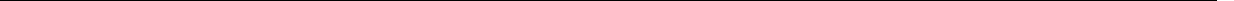
Fig. 2 FBXO32 induces genes critical for promoting a suitable microenvironment for EMT progression. a Volcano plots showing signi fi cantly differentially expressed genes upon FBXO32 depletion in HMECs undergoing EMT. b Heat map showing standardized expression (Z-scores) of key downregulated genes along with EMT markers, upon FBXO32 depletion in HMEC cells undergoing EMT for 4 days. c , d Representative immunoblot ( n = 3) of an individual membrane array for human secretory MMPs ( c ) and cytokines ( d ) from HMEC cells upon FBXO32 depletion, and bar-graph showing their quanti fi cations on the right side. Control wells act as loading controls in our analysis to allow comparison of different blots. e , f GO analysis of downregulated ( e ) and upregulated genes ( f ) upon FBXO32 knockdown in HMECs that underwent EMT for 4 days. g Heat map showing standardized expression (Z-scores) of differentially expressed genes upon FBXO32 depletion in Epithelial HMEC cells, HMEC that underwent EMT for 4 days and treated with control siRNA-pool or siRNA-pool against FBXO32. h , i The mRNA levels of downregulated genes ( h ) and upregulated genes ( i ) during EMT in control and FBXO32 knockdown HMECs that underwent EMT for 4 days were measured relative to CTCF via RT-PCR, and the results were plotted on the y -axis. Error bars represent the SEM of three independent biological replicates ( n = 3). * p < 0.05, ** p < 0.01, *** p < 0.001, Student ’ s t test. See also Supplementary Figs.